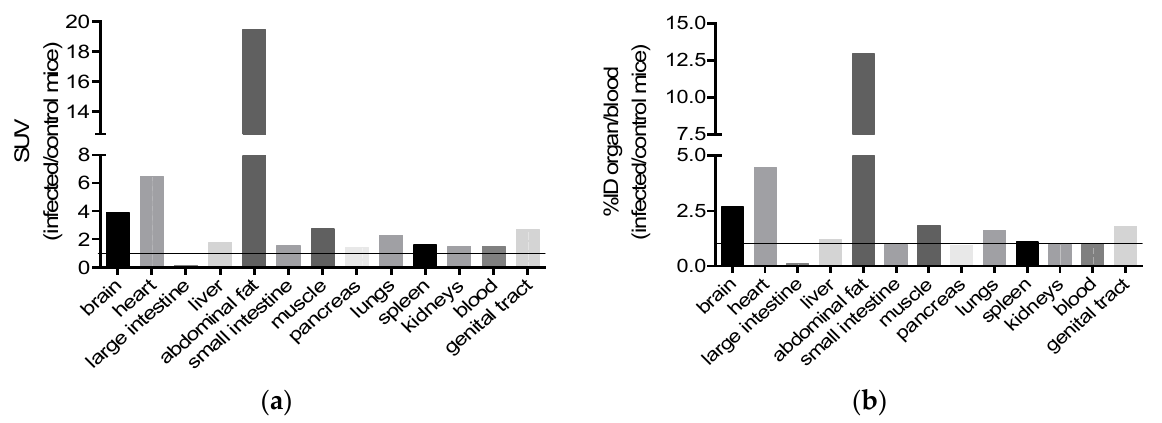
Figure 6. Biodistribution of the iodinated 363 molecules. The biodistribution ratios (infected/control mice) were determined following organ sampling at 24 h pi . Ratio are presented for ( a ) SUV = ((activity in organ/g of organ)/injected dose) × mouse body weight (g) and ( b ) the %ID/g of organ/%ID/g of blood.